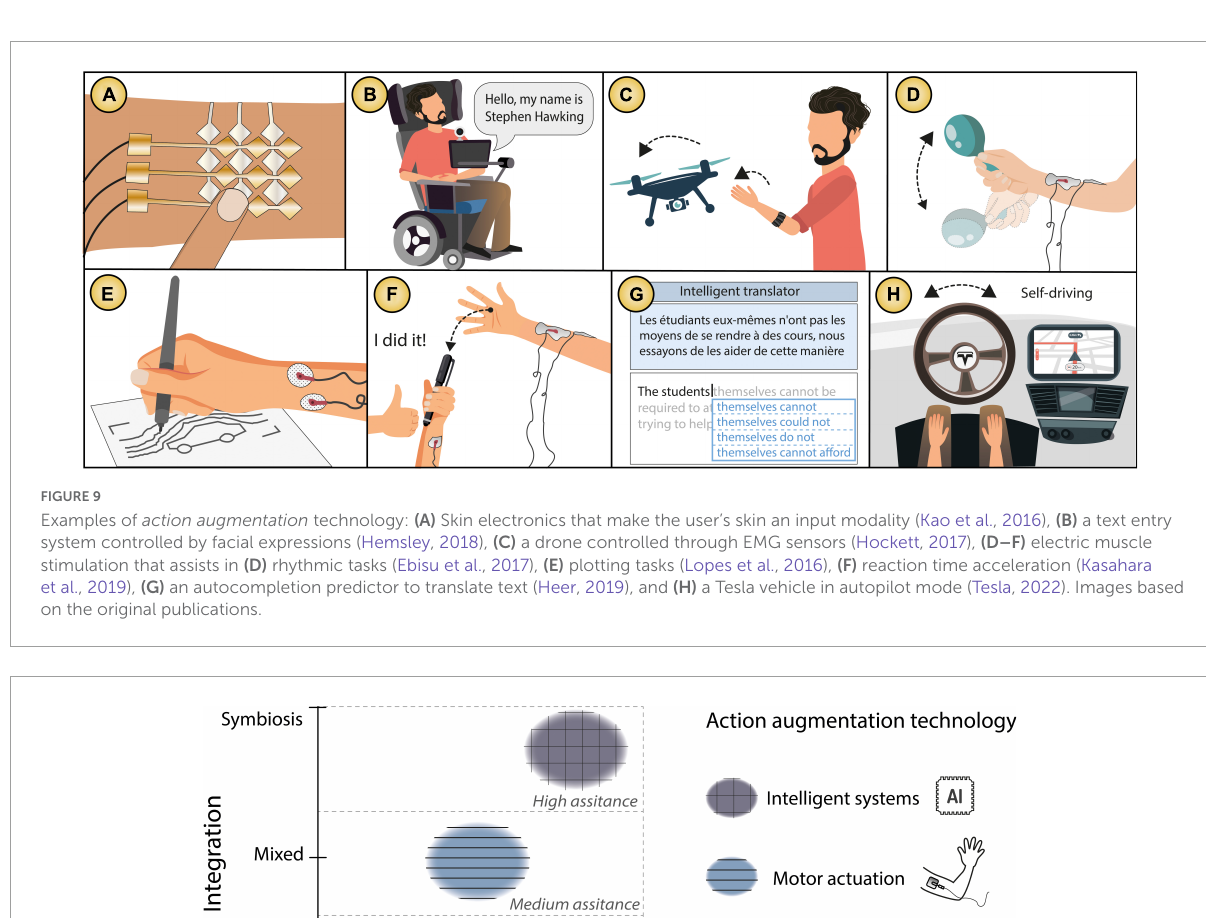
sensors on the user’s body, allowing the skin to be used as a finger input surface. Indeed, it has been suggested that on-skin input produces a higher SoA compared with traditional button-press (Coyle et al., 2012) and touchpad (Bergstrom-Lehtovirta et al., 2018a)